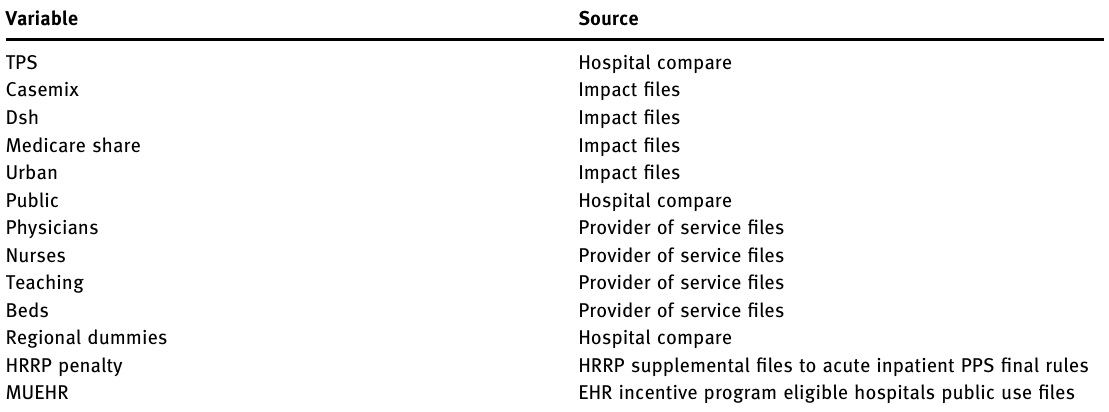
Table A2: List of variables and databases